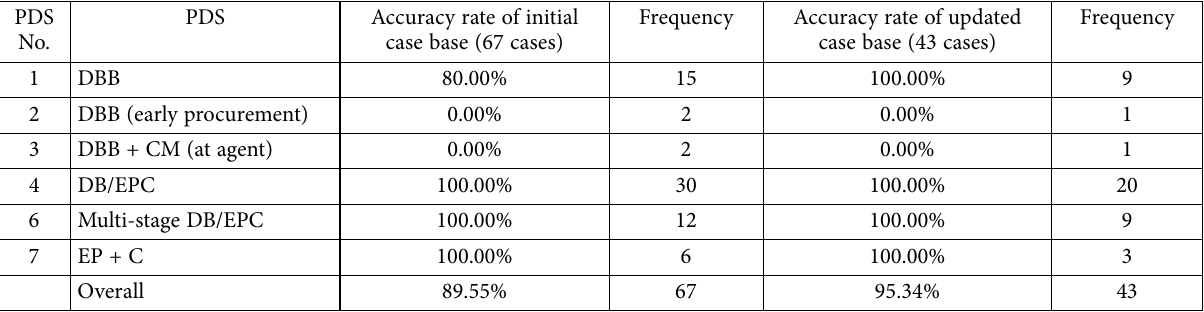
Table 8. The partial and overall accuracy rate for the PDS selection